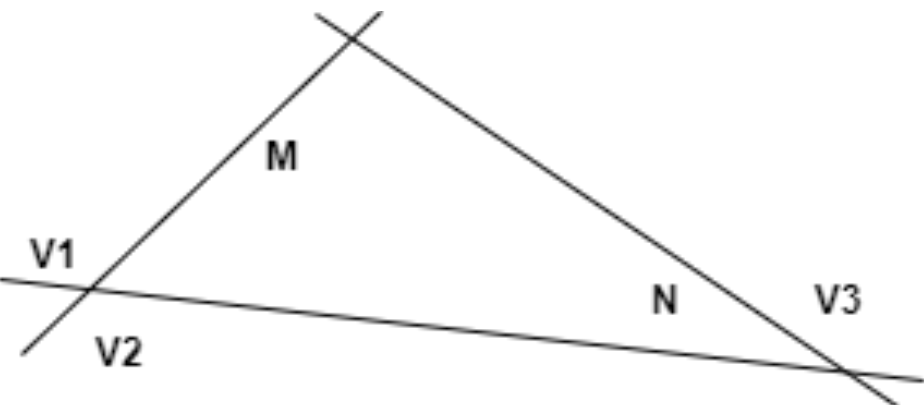
Figure 9. A set of three linear constraints constructs a closed area focusing on objects M and N .